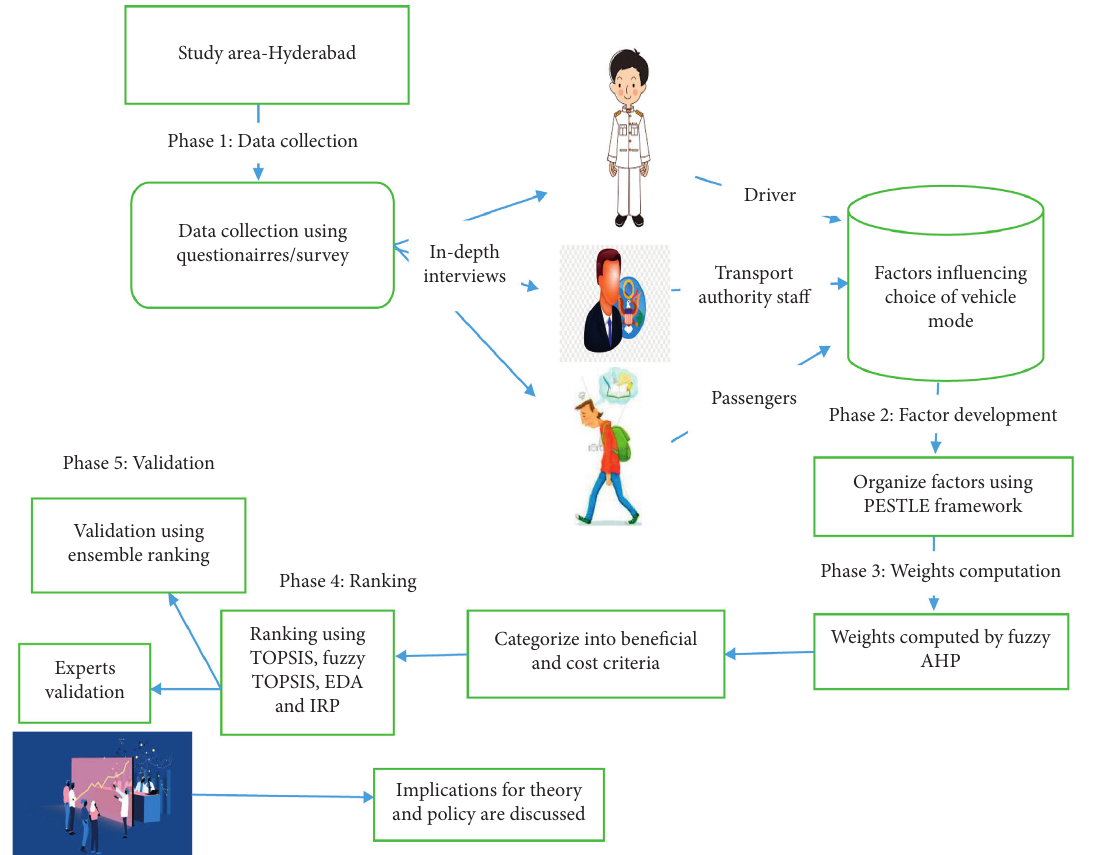
Figure 3: Methodology adopted for the